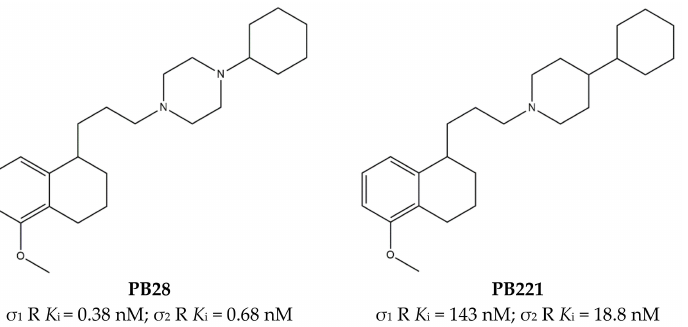
Figure 15. PB28 and PB221 structures and K i values for σ 1 receptor ( σ 1 R) and σ 2 receptor ( σ 2 R)